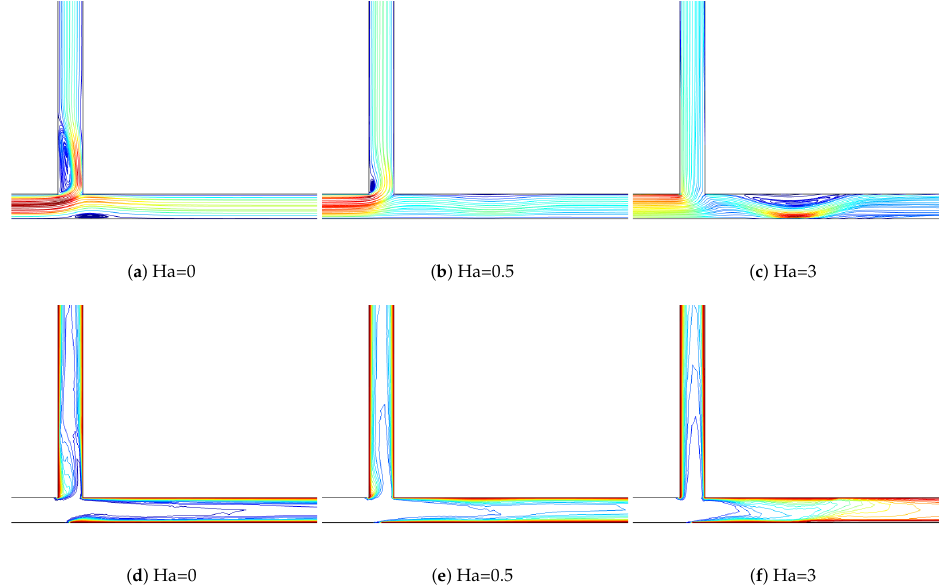
Figure 5. Streamline ( a – c ); and isotherm ( d – f ) distribution for various values of Hartmann numbers (Re=300, φ = 0.02).